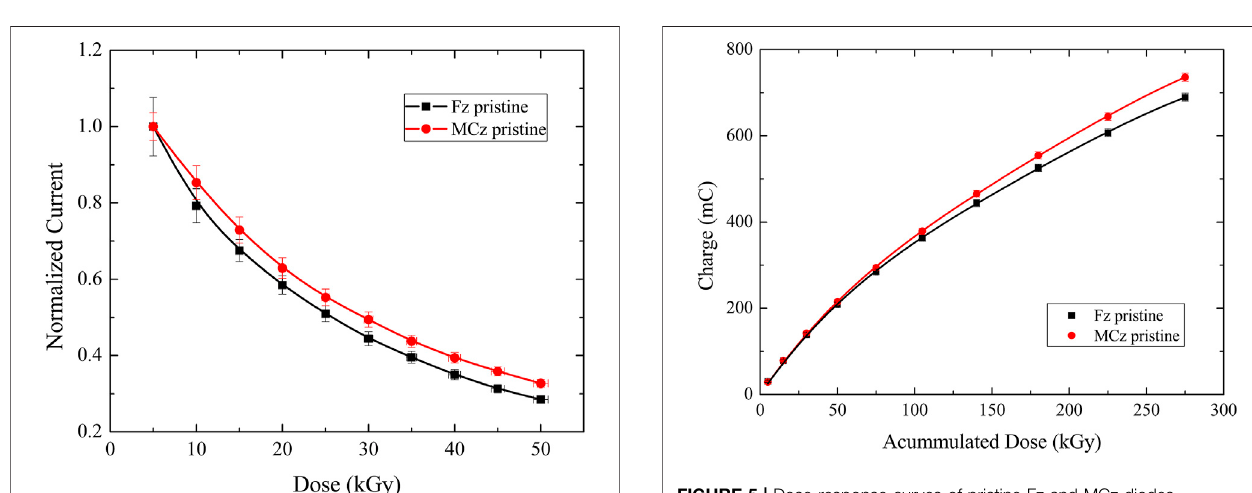
FIGURE 5 | Dose-response curves of pristine Fz and MCz diodes covering the dose range of 275 kGy. The best fi t ofthe data isachieved with a fourth-order polynomial